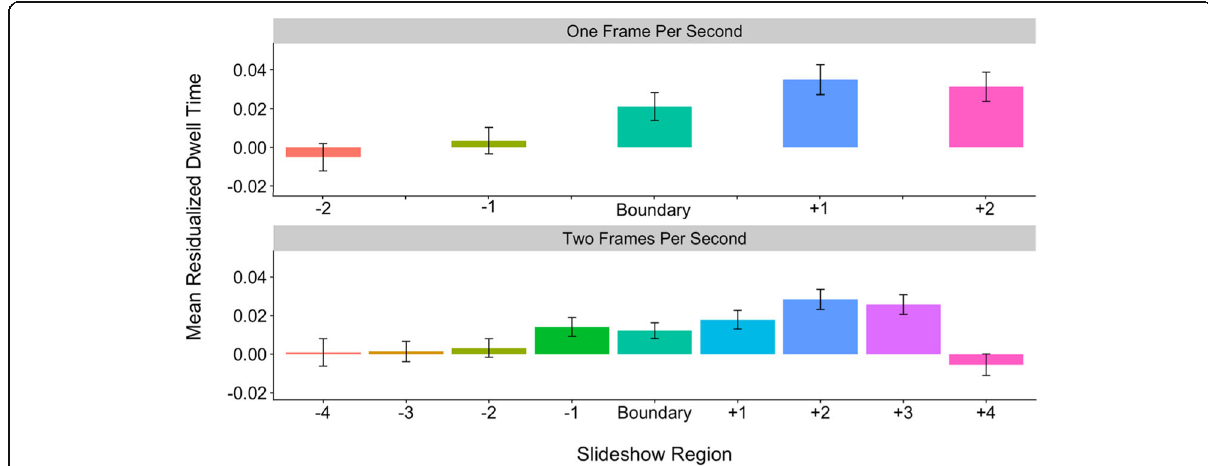
Fig. 4 Average residualized dwell times (± standard error) by region, resolution, and slide type for coarse-level boundaries. Slides occurring one and two pre-boundary and one and two post-boundary were included. Bars in the same color represent the same slide content across 1-fps and 2-fps slideshows (i.e., these are the matched slides). fps frames per